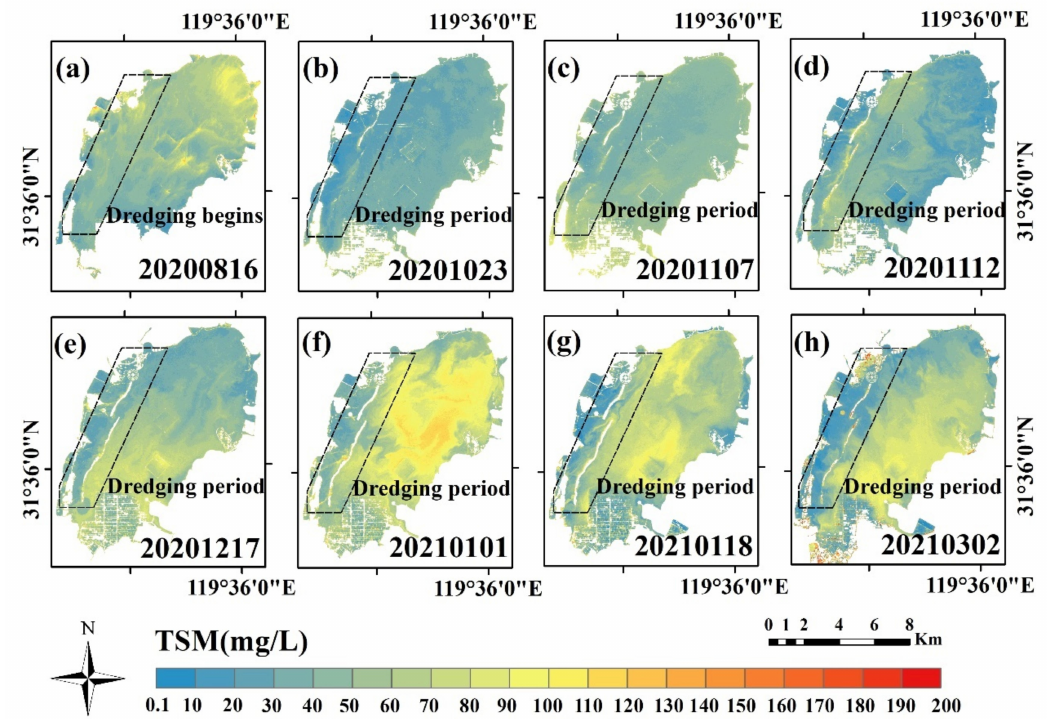
Figure 9. Sentinel-2 images showing temporal changes in the spatial distribution of TSM concentration in Changdang Lake during the second stage of ecological dredging. ( a – h ) indicates the process of building a cofferdam and removing silt in the western lake area of Changdang